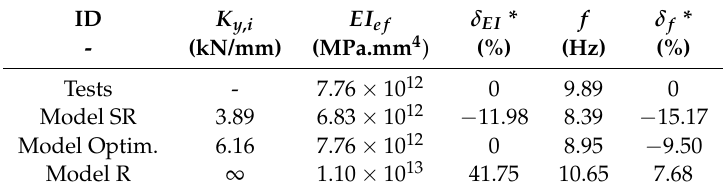
Table 3. Results of effective bending stiffness ( EI ef ) and natural frequency ( f